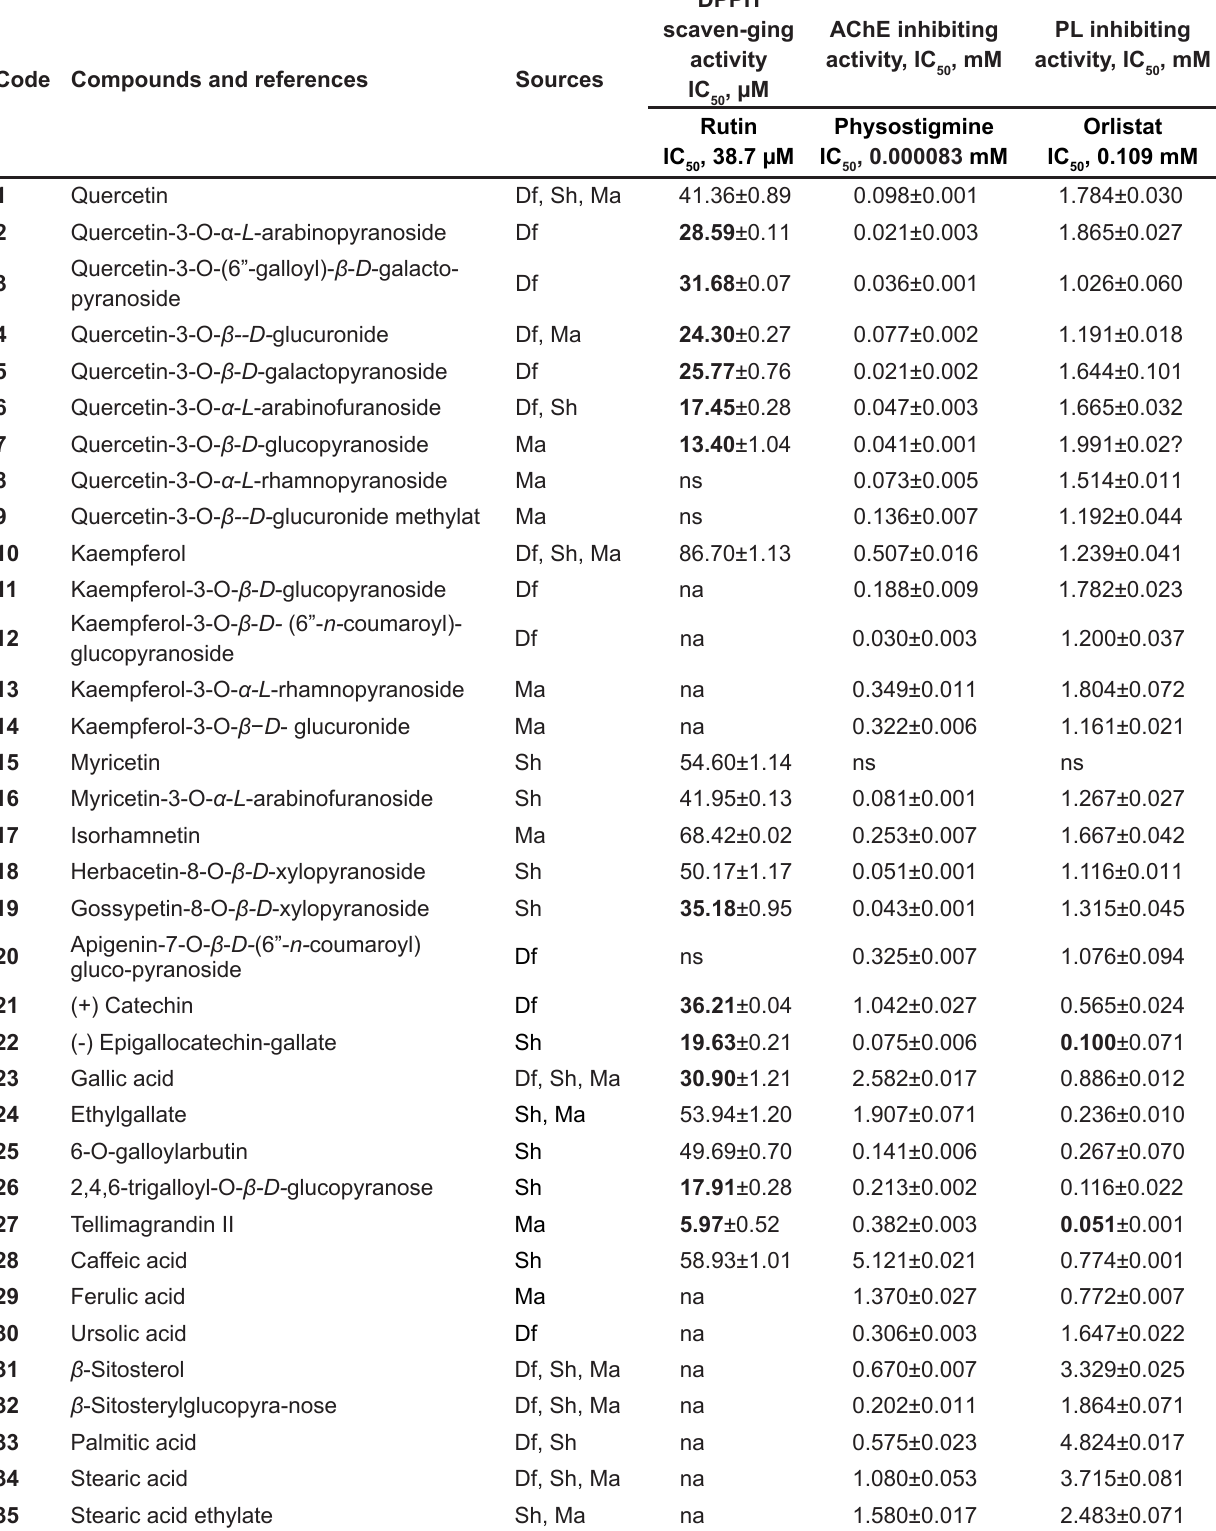
Table 3. Isolated compounds and their biological